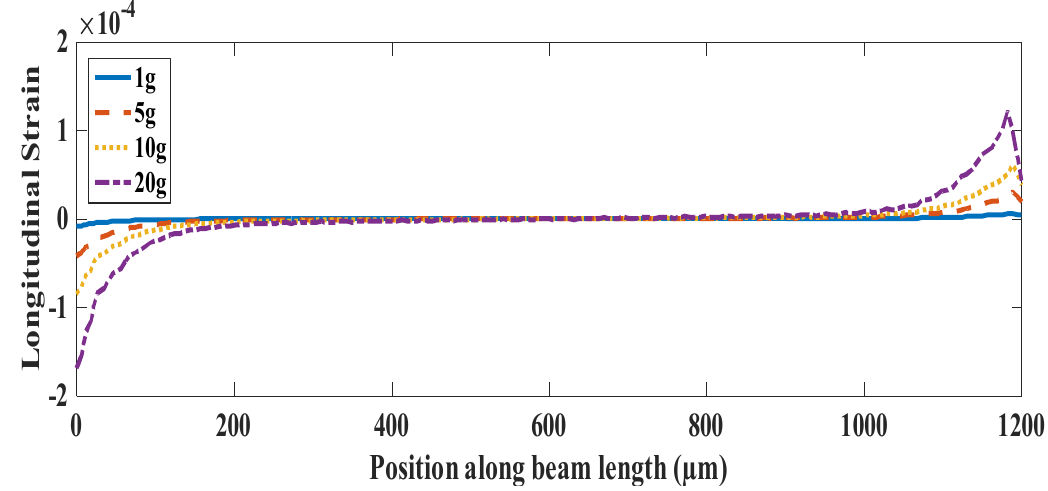
Figure 9. Longitudinal strain for different perpendicular